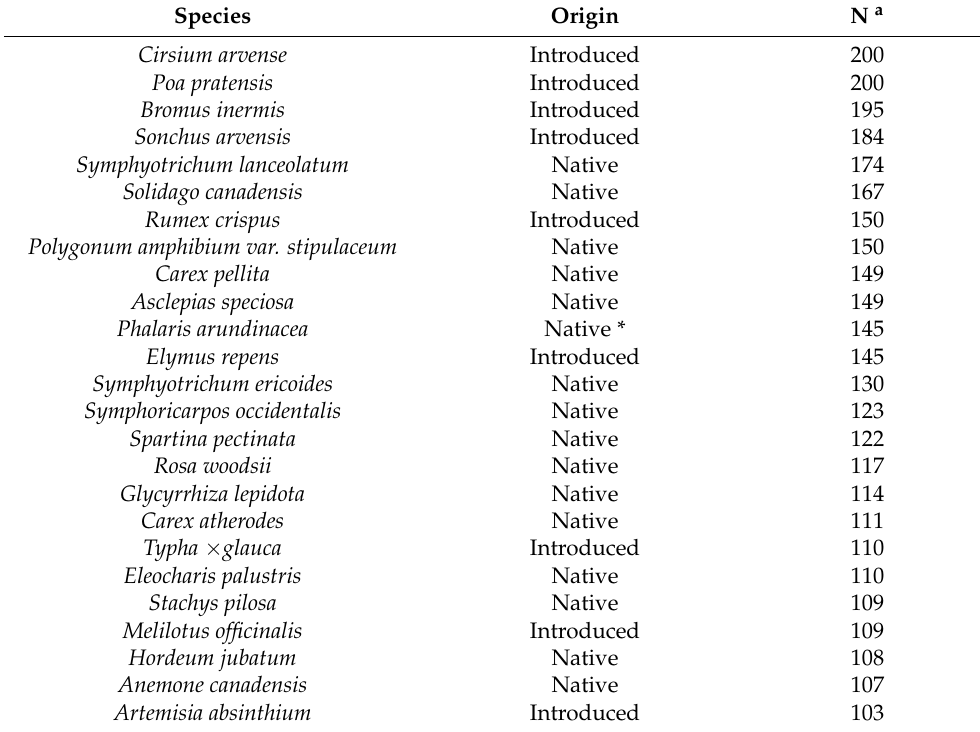
Table 1. Species identified in at least 50% of the wetlands surveyed.